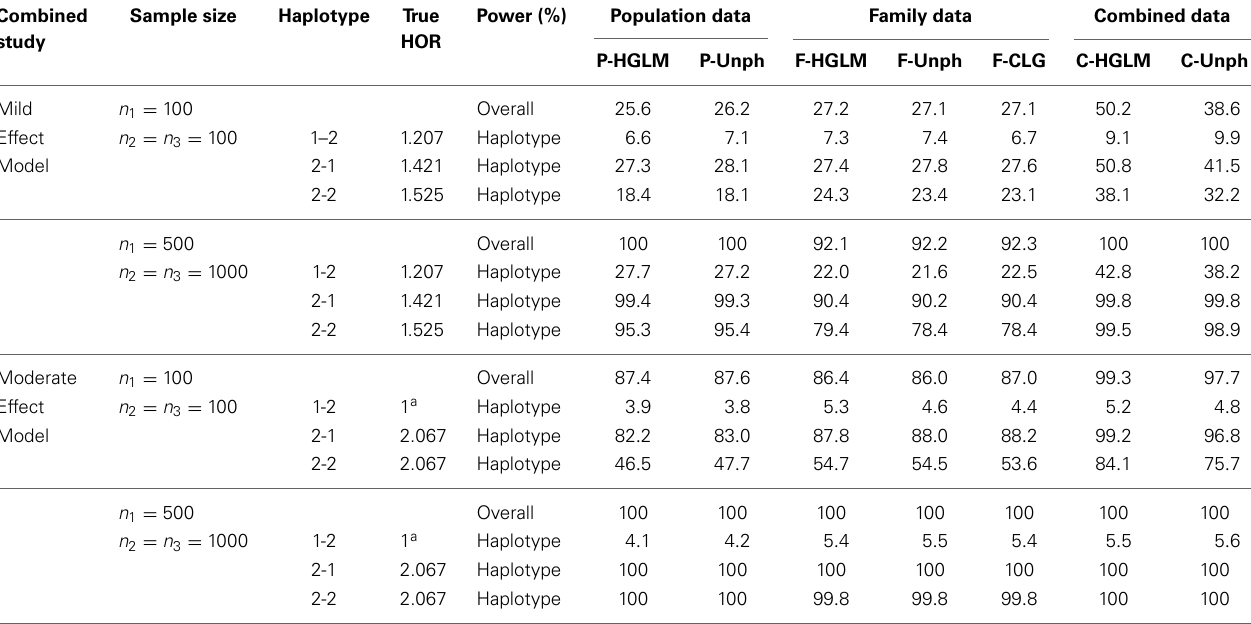
Table 2 | FPR and Power (%) at 5% significance level for (1) 2-locus mild effect model and (2) moderate effect model under varying sample